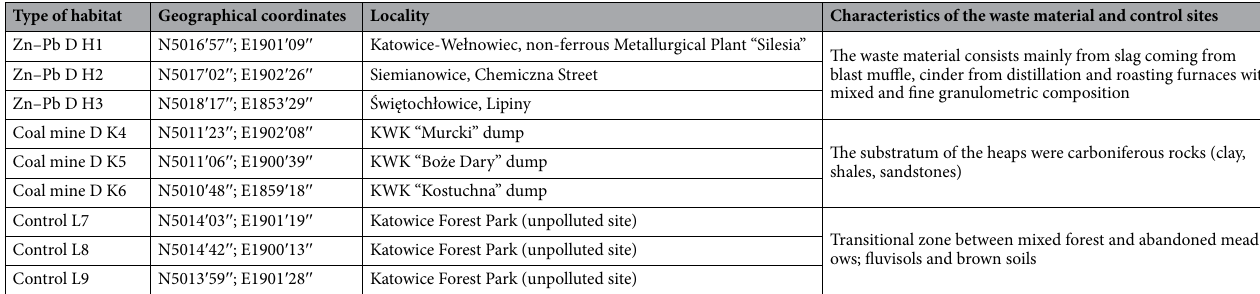
Table 1. Locality and characteristics of the waste material from Zn-Pb dumps, coal mine dumps and control